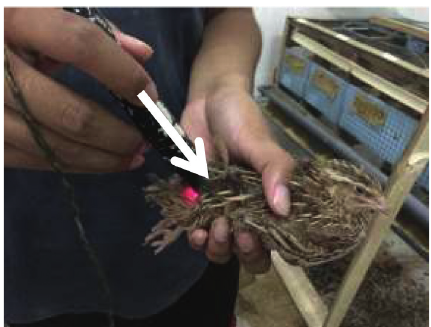
Figure 4: Laser puncture shooting at the Wei Gen